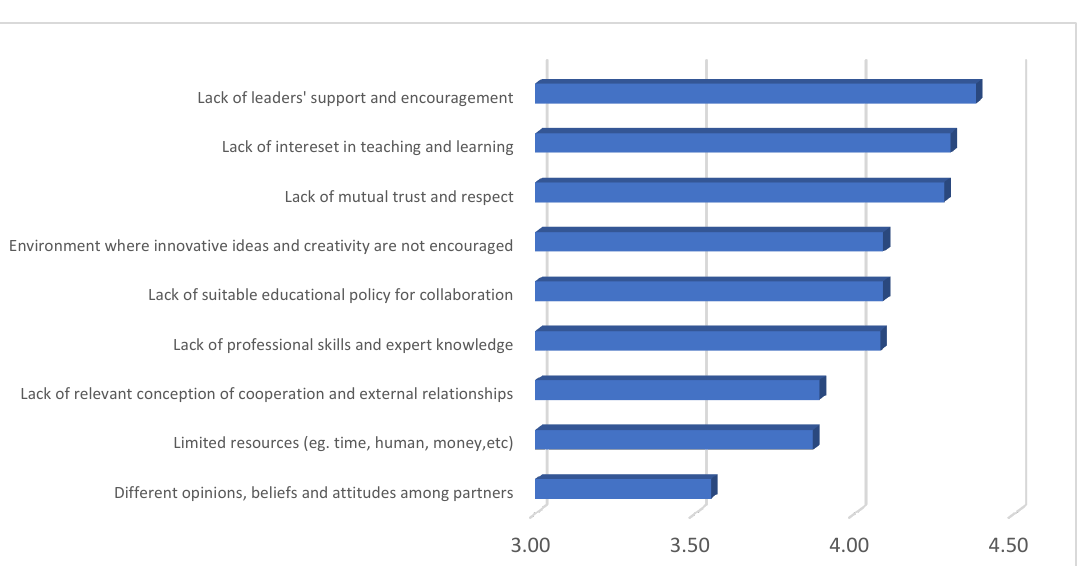
FIGURE 1: STUDENT TEACHERS' PERCEPTION OF FACTORS THAT IMPEDE THEIR LEARNING AND COLLABORATION WITH